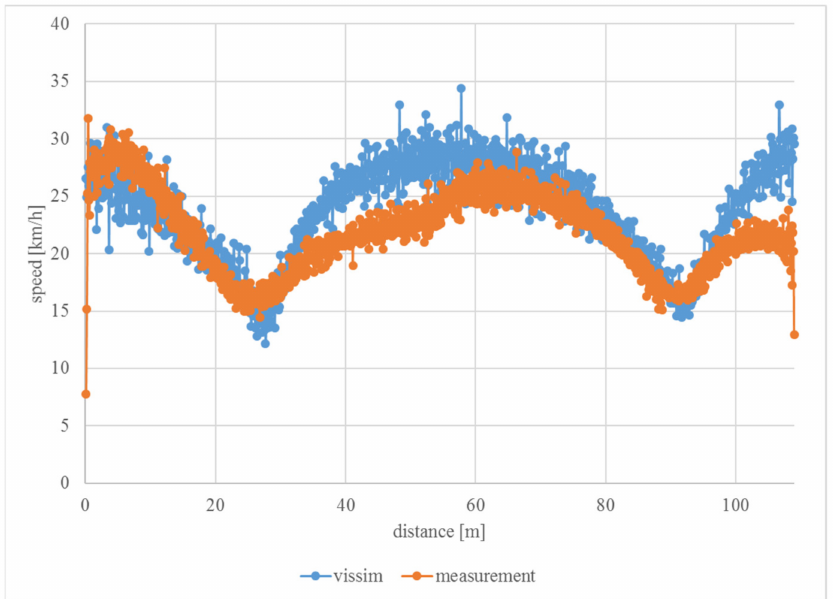
Figure 11. Comparison of speed profiles on the measured street section, heading southbound, source: own.